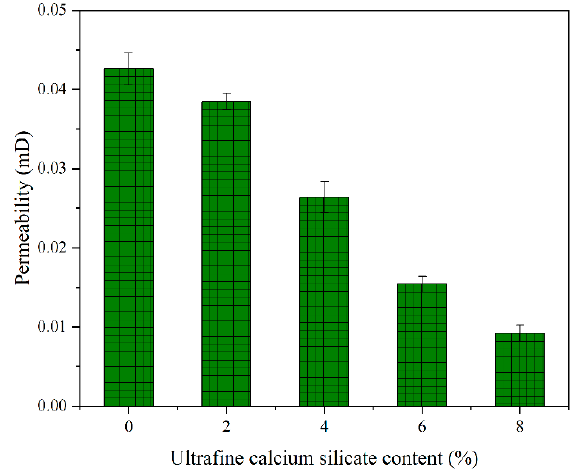
Figure 3. Permeability of ultrafine calcium silicate cement paste.